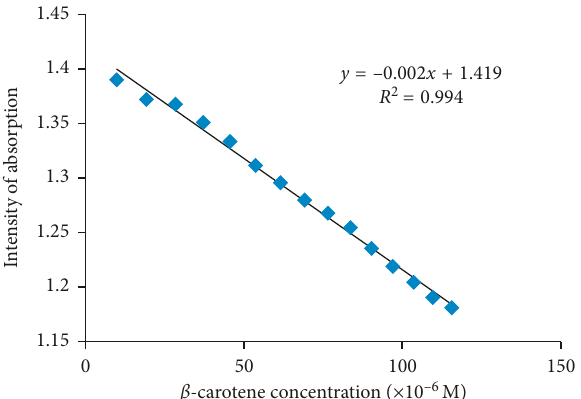
Figure 4: The dependence between the intensity of absorption of the hybrid plasmon and the β -carotene concentration.